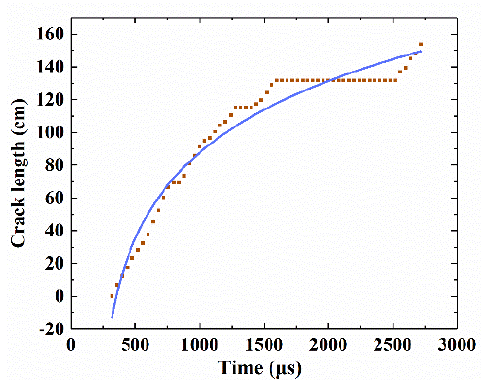
Figure 14. Length-time curve of carbon dioxide phase transition fracturing (CDPTF) crack.